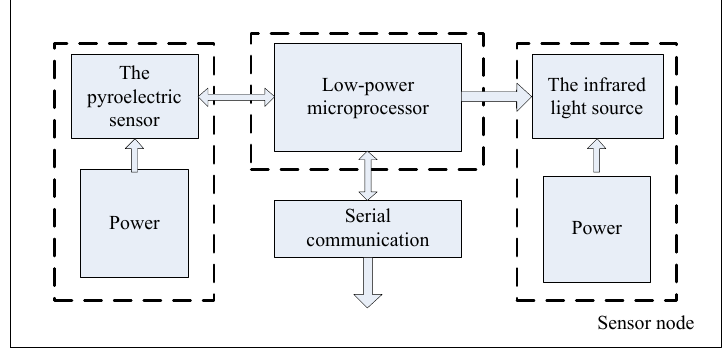
Figure 1. Sensor node monitoring modules.